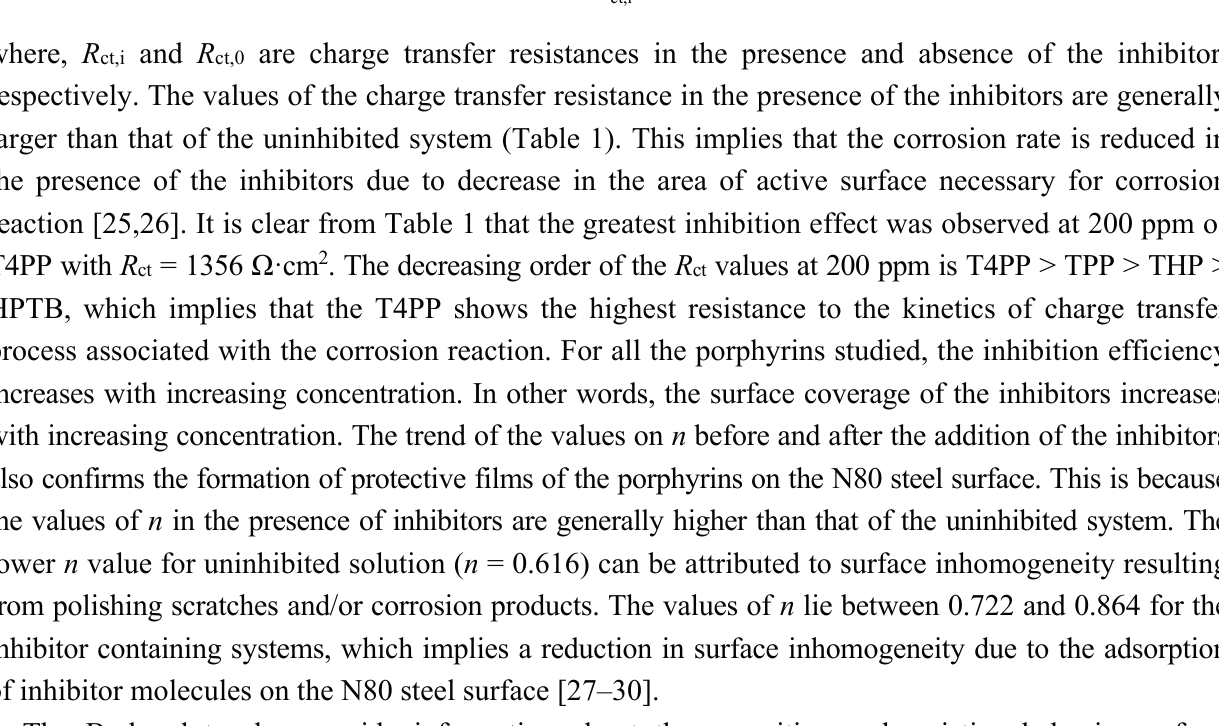
Table 1. The values of η % were calculated using the equation: